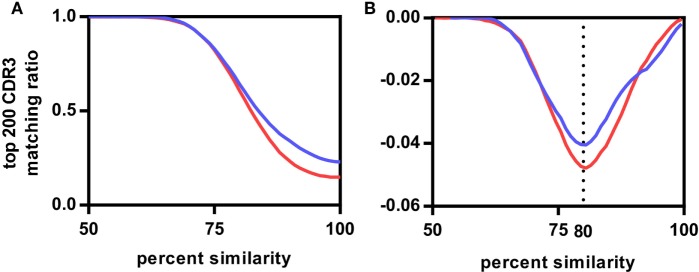
Influence of complementary-determining region 3 (CDR3) sequence similarity on CDR3 repertoire overlap between rats. (A) Average fractions of top 200 CDR3s of the Modified Vaccinia virus Ankara (MVA)-HF vaccination group shared with all CDR3s of other samples. Samples were divided into two groups having either the same antigen (MVA-HF group samples, blue curve) or different antigens (aluminum hydroxide, benzo[a]pyrene-tetanus toxoid, tetanus toxoid, and NEG samples, red curve), samples from overlapping antigens (in this case the MVA group) were excluded from this. Both curves follow a similar sigmoidal behavior. (B) First derivative of both curves. Inflection points align at 80% CDR3 amino acid similarity.